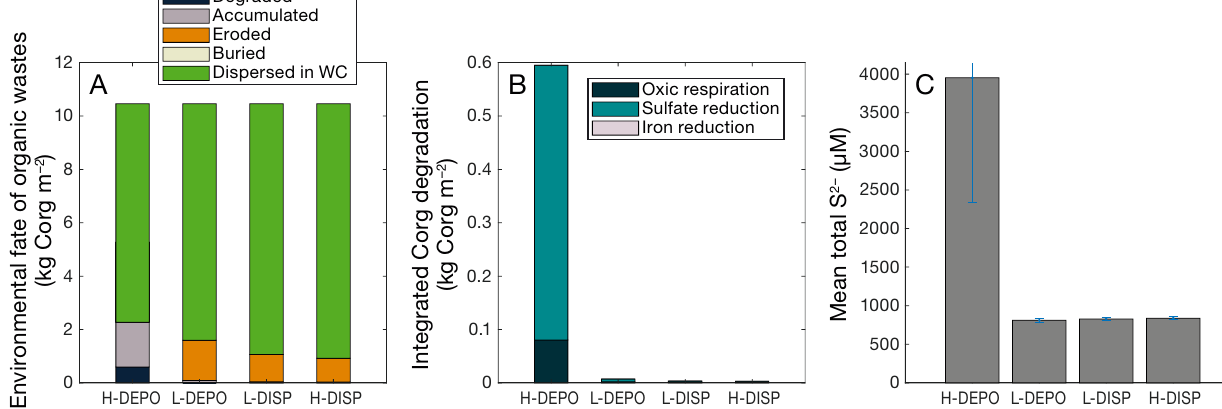
Fig. 5. Integrated benthic processes calculated for a representative fish farm production cycle according to Table 1. Simula- tions were carried out assuming a feed wastage of 3%, twice-per-day feeding (for 20 min each), and a constant water depth of 20 m below the fish cage (35 m in total). Simulations are presented for 4 different hydrodynamic scenarios covering poorly (H- DEPO) to well-flushed aquaculture sites (H-DISP) according to Table 3. (A) The fate of organic wastes released at the base of the fish cage. WC: water column. (B) Integrated total C org degradation and contribution of different degradation pathways to organic waste degradation (not ambient particulate organic carbon). (C) Mean (±1 SD) total S 2− concentration